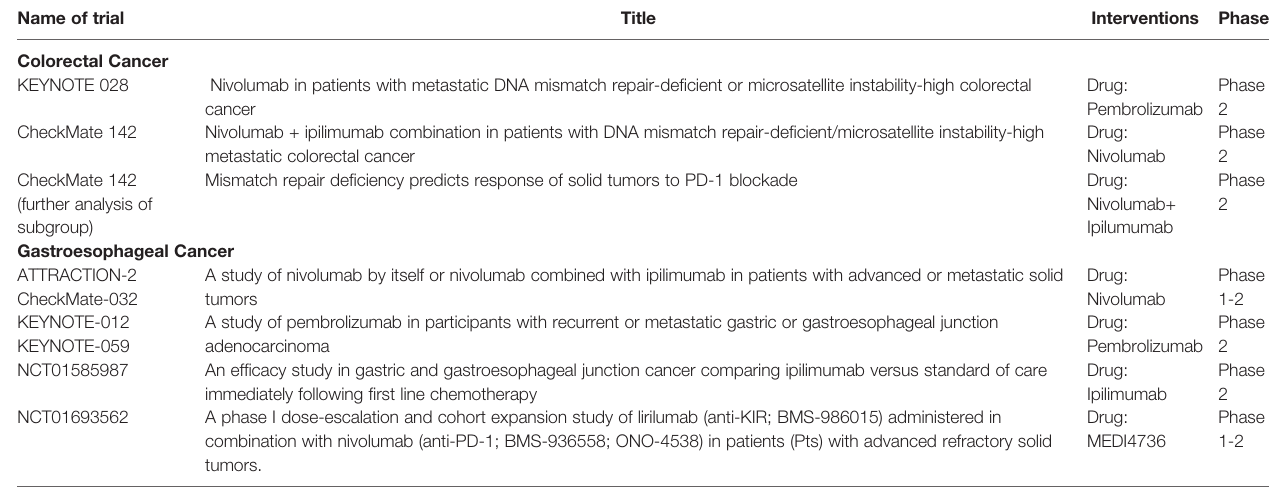
TABLE 1 | Landmark trials of immunotherapy in